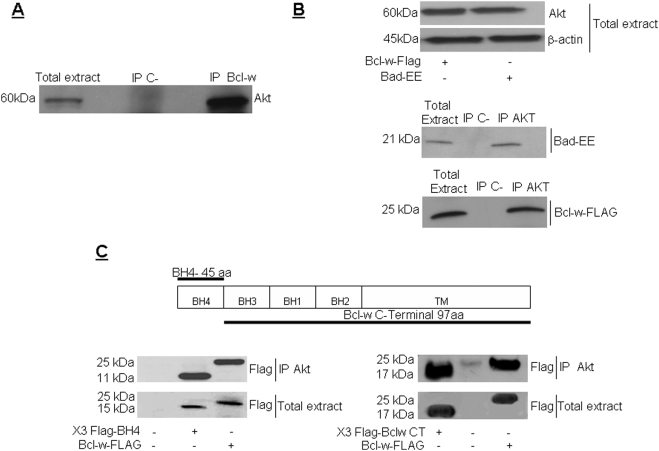
Akt interacts with Bcl-w.(A) Co-immunoprecipitation of endogenous Akt with Bcl-w. Wt HeLa cells were lysed and 1 mg of protein extract immunoprecipitated using an anti-Bcl-w antibody. Immunoprecipitates and total lysates (50 µg) were separated on 12%SDS polyacrilamide gel and blotted with an anti-Akt antibody. As negative control, proteins were incubated with beads without antibody (B) Co-immunoprecipitation of transfected Akt with FLAG-Bcl-w or EE-BAD. HEK-293 cells were tansfected with 2 µg of HA-Akt and 2 µg of FLAG-Bcl-w or EE-BAD cDNAs, as indicated. After 48 hr, cells were lysed, and 1 mg of protein extract was immunoprecipitated using an anti-HA antibody. Immunoprecipitates were subsequently blotted with anti-HA, anti-Flag or anti-EE antibodies, as indicated. (C) HEK-293 cells were transfected with 2 µg of either wt-Bcl-w cDNA or the deletion mutants, Bcl-w/BH4 or Bcl-w/CT, as indicated. Protein extracts were immunoprecipitated using an anti-Akt antibody. Immunoprecipitates and total lysates were resolved on 12%SDS-PAGE and transferred to Hybond-C nitrocellulose. Membranes were incubated with an anti-FLAG antibody. Both deletion mutants, Bclw/BH4 and Bclw/CT, immunoprecipitated with Akt.